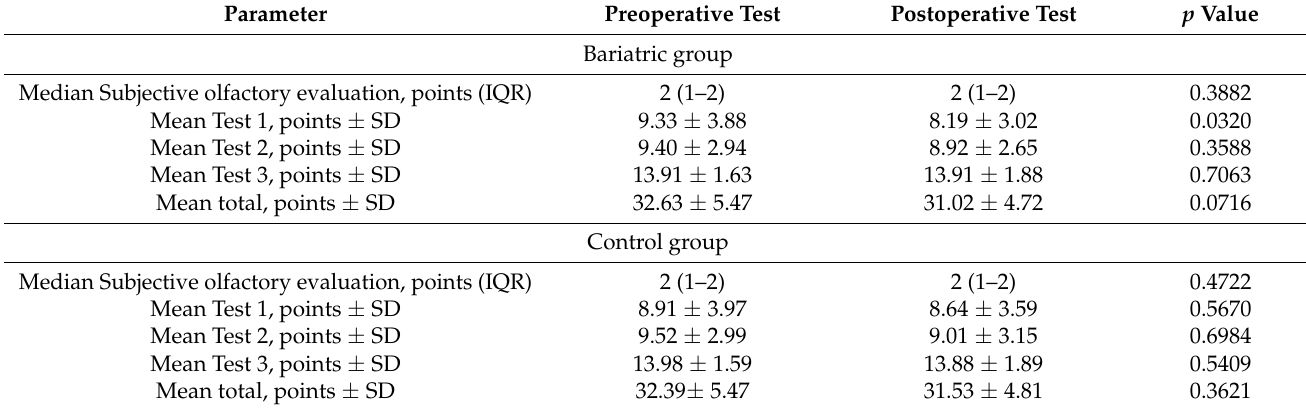
Table 2. Test results in bariatric and control groups.